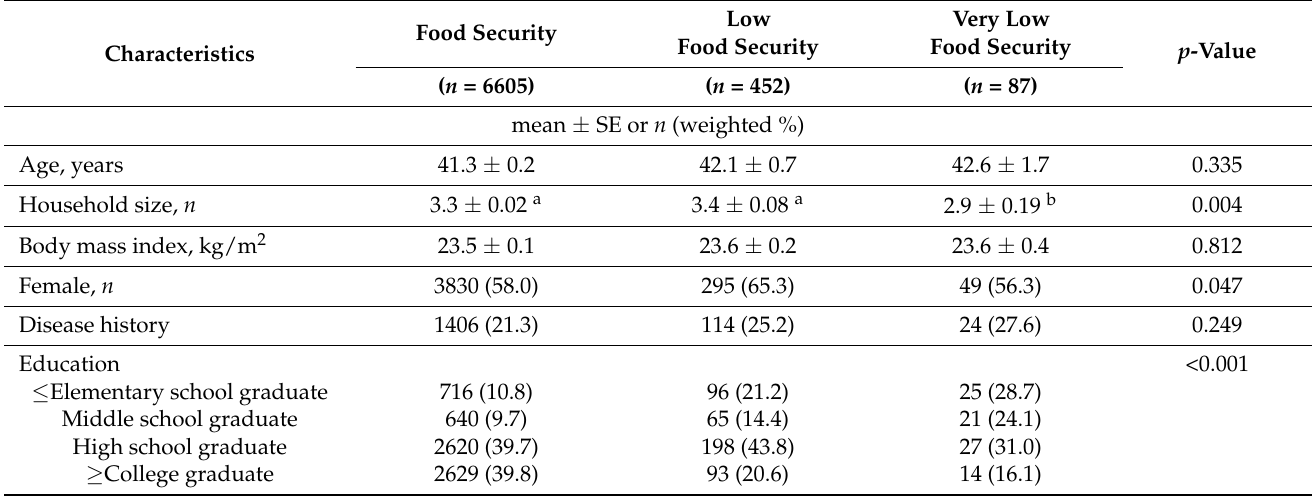
Table 1. Socio-demographic characteristics of subjects according to household food security